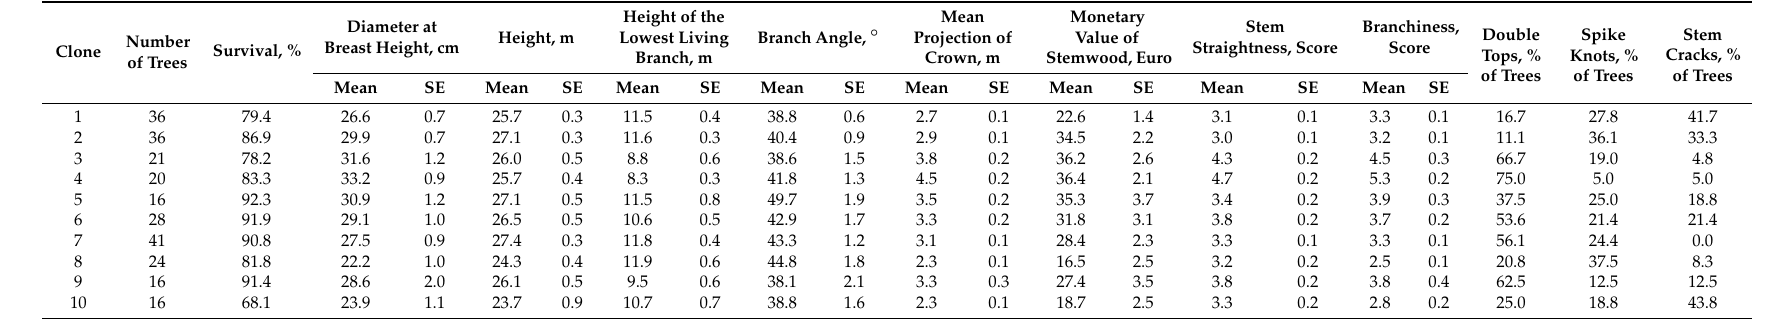
Table 2. Clone means with standard errors (SEs) for studied traits.